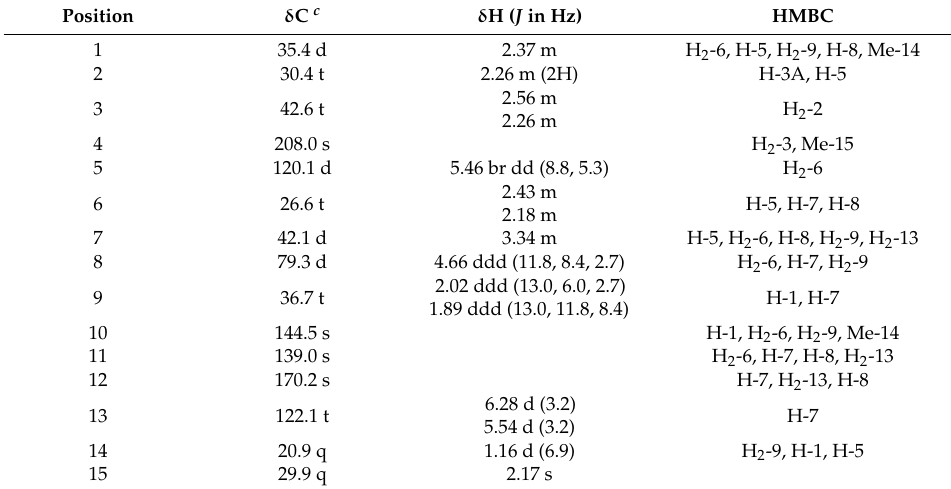
Table 1. 1 H and 13 C-NMR data of inuloxin E ( 1 ) a , b